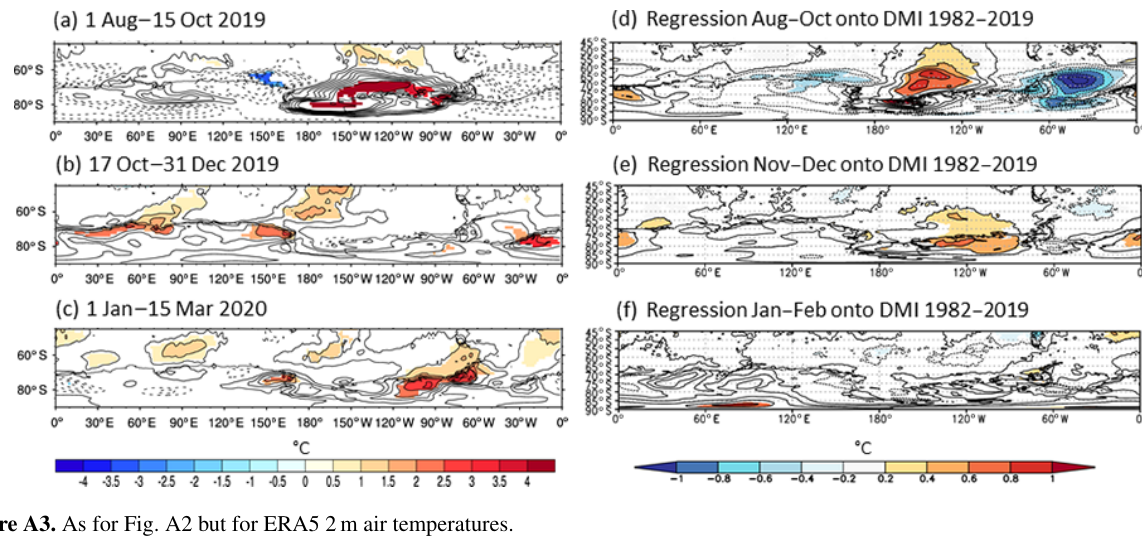
Figure A3. As for Fig. A2 but for ERA5 2m air temperatures.